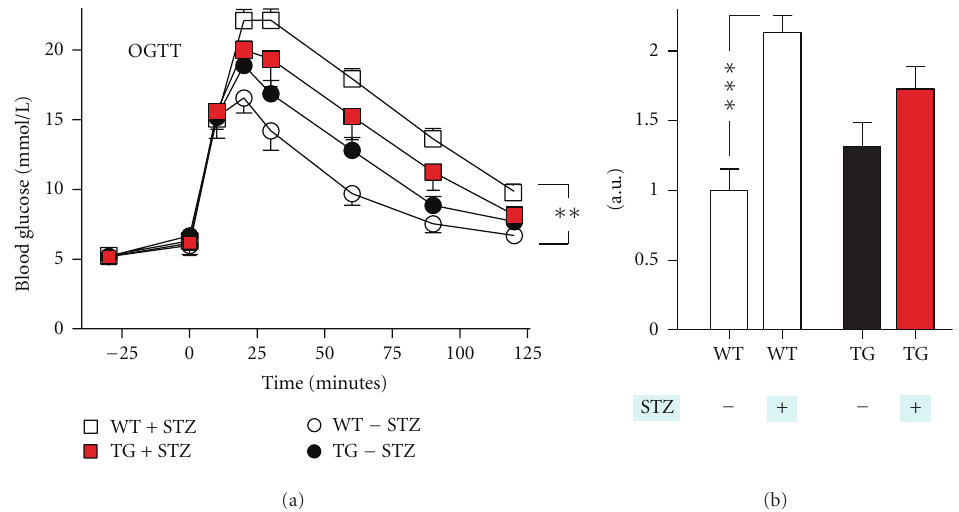
Figure 3: E ff ect of β -cell specific overexpression of GPR39 on oral glucose tolerance test (OGTT) after low-dose STZ treatment. (a) OGTT performed 35 days after STZ treatment (see Figure 2) in tetGPR39/RIP-rtTA transgenic (TG) mice with STZ treatment (red square) n = 11, in wild-type littermates (WT) with STZ treatment (open squares) n = 11, in WT mock-treated mice (open circles) n = 6, and in TG mock- treated mice (black circles) n = 7. ∗∗ P < 0 . 01 (repeated measures (mixed model) ANOVA performed WT+STZ versus WT − STZ). (b) area under the curve, ∗∗∗ P < 0 . 001 (Mann-Whitney t -test). a.u.: arbitrary units.